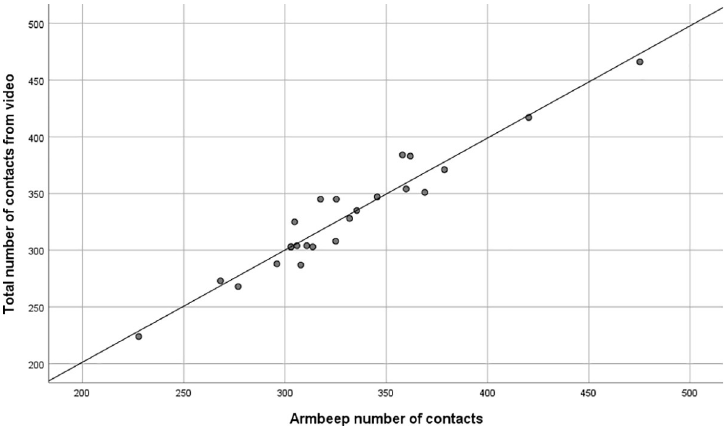
Fig 4. Scatter plot of the relationship between total number of shots collected with video analysis and Armbeep sensor number of contacts.